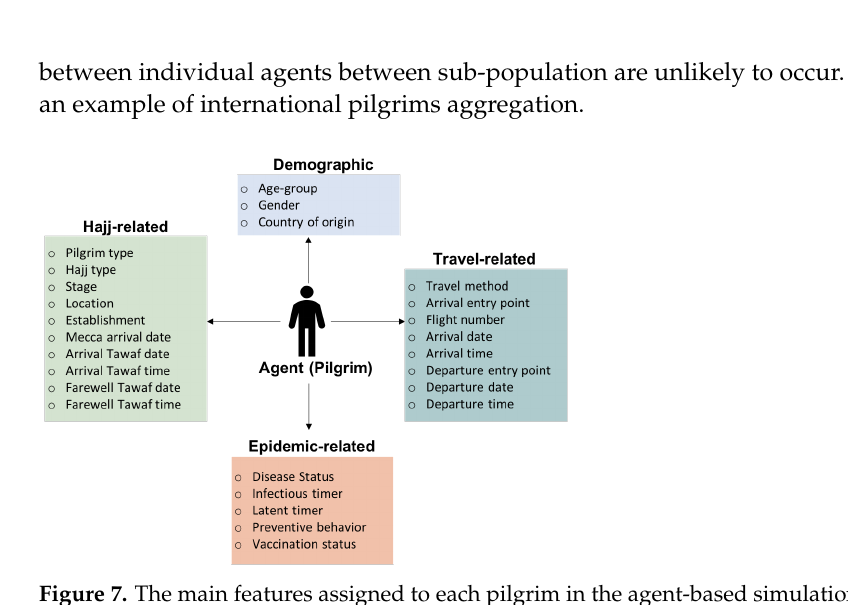
Figure 7. The main features assigned to each pilgrim in the agent-based simulation model.